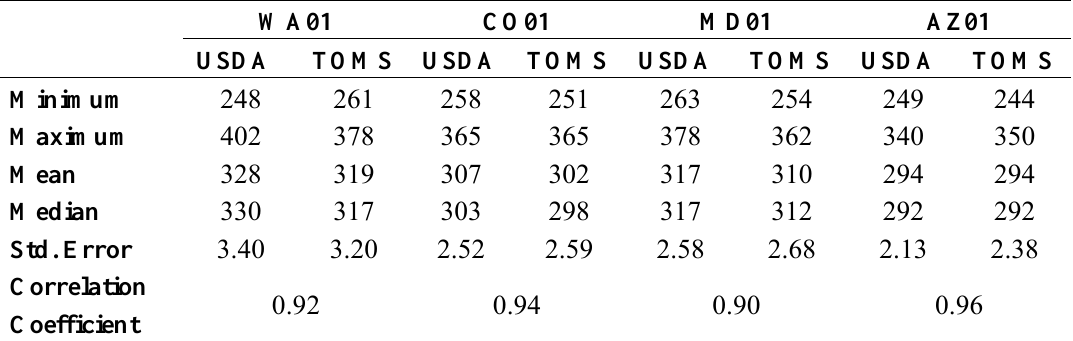
Table 2. Monthly statistical analysis of total ozone data collected by four ground-based USDA stations and the TOMS Data (1999–2005, unit: